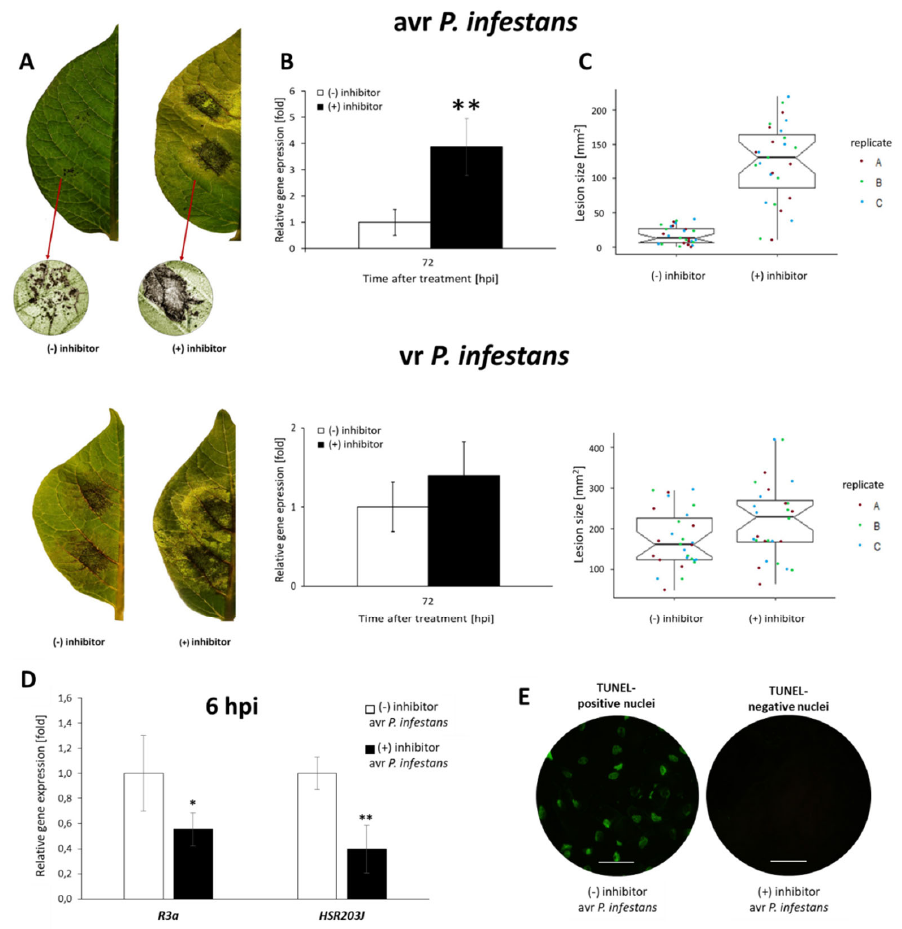
Figure 8. PRMT5 activity is required in potato resistance to avr P. infestans . Potato leaf surface (with or without PRMT5 inhibitor) covered by late blight symptoms ( A ), Pitef1 gene expression ( B ) and meas ‐ urement of lesion size at 72 hpi after challenge inoculation with avirulent or virulent P. infestans (MP977) ( C ). Gene expression of R3a and HSR203J ( D ) and TUNEL assay at 6 hpi ( E ). Categorical scatter plots show lesion diameters of twelve inoculated sites from three biological replicates marked with three colors. Gene expression values represent the means of data ± SD of at least three independ ‐ ent experiments, each with at least three biological replicates. Asterisks indicate values that differ sig ‐ nificantly from mock ‐ inoculated (water treatment) potato leaves at α < 0.05 ( * ) and α < 0.01 ( ** ).